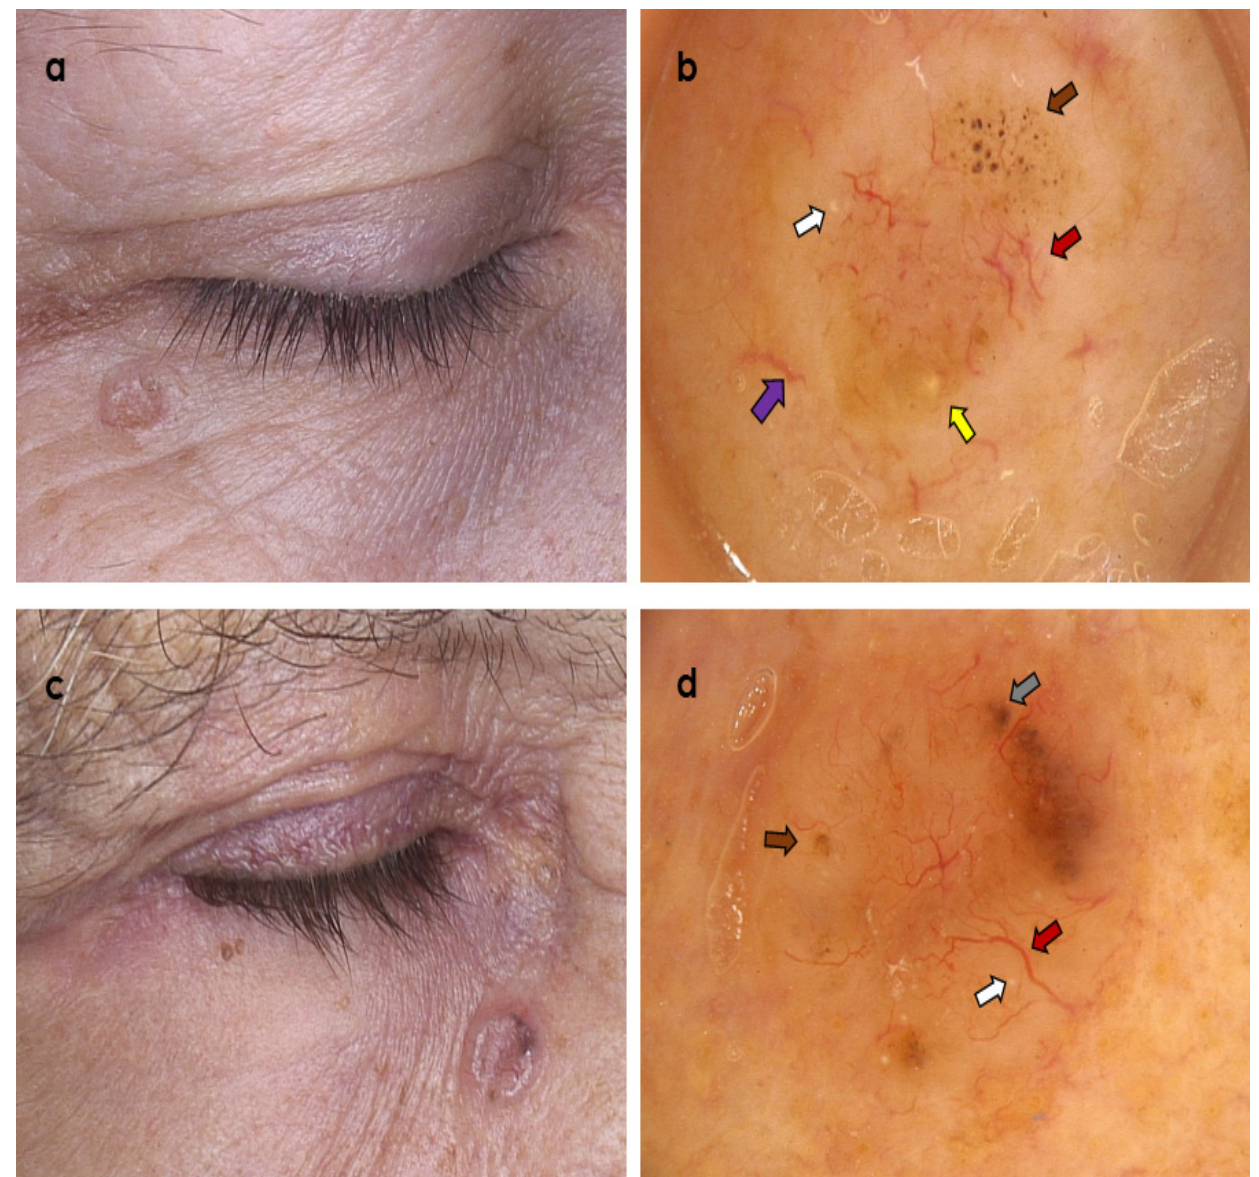
Figure 1. Two clinically similar tumours presenting as whitish plaque within the cheek area. ( a , b ) Desmoplastic trichoepithelioma; dermoscopy shows branched (arborizing) vessels (red arrow) over whitish background (Fotofinder Vexia; Camera Medicam 800 HD, ×20 magnification). ( c , d ) Morpheaform basal cell carcinoma; dermoscopy shows central ulceration (black arrow) and branched (arborizing) vessels (red arrow) over whitish background, starry milia-like cysts (white arrow) and Multiple Aggregated Yellow-White Globules (yellow arrow) (Fotofinder Vexia; Camera Medicam 800 HD, ×20 magnification).